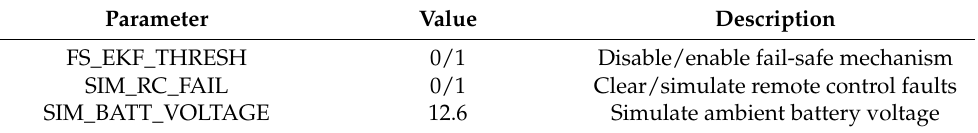
Table 4. Parameter se tt ings in the Remote-Control System failure simulation.